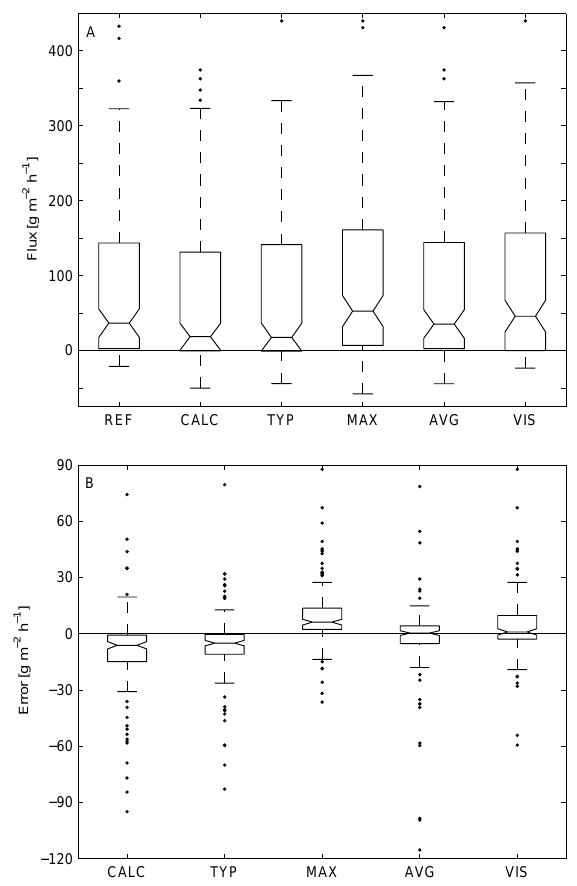
Fig. 5. DEC simulation results. Panel ( A ) gives the statistics of the DEC fluxes of H 2 O noise and the EC fluxes of H 2 O. Panel ( B ) shows the error analysis. The DEC fluxes were calculated using the five lag time methods (Sect. 2.4) and evaluated against the reference EC fluxes (REF, Sect. 3.2). The line in the middle of each box is the median. The lower and upper line are the 25th and 75th percentile, the distance between them is the interquartile range. The error bars extend from the top or bottom of the box to the furthest data value within 1.5 times the interquartile range. The values beyond the error bars are outliers. The notches show the 95% confidence interval for the median. If notches of two boxes do not overlap, the difference between medians is statistically